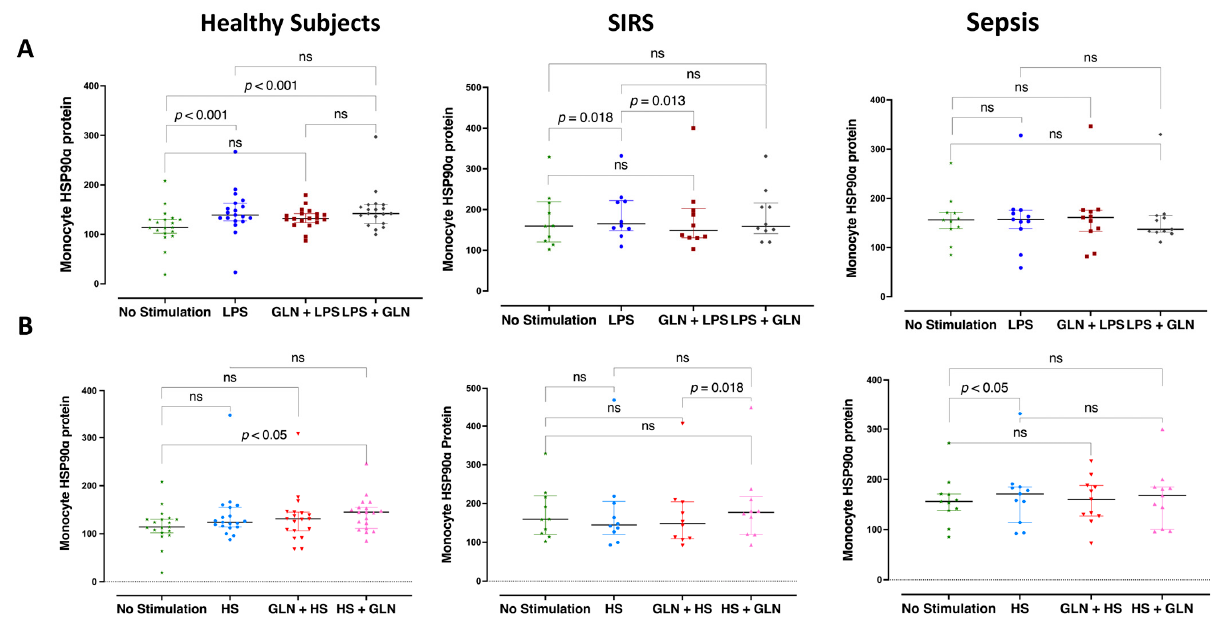
Figure 3. Glutamine effect on heat shock protein 90 α expression in monocytes (mHSP90 α ) within 4 h of LPS or HS stimulation. ( A ) LPS increased the mHSP90 α expression in the PBMCs of healthy subjects and patients with SIRS (trauma) but not in patients with sepsis. Glutamine before LPS decreased the induced mHSP90 α protein expression in SIRS but increased it in healthy subjects when given after LPS. Either way, glutamine did not affect the monocyte HSP90 α protein expression in sepsis. ( B ) HS increased the mHSP90 α expression in the PBMCs in all groups, almost 10-fold in sepsis compared to the other groups. Glutamine before or after HS stimulation showed a non-significant decreasing trend in sepsis but a significant increase in SIRS and healthy subjects when given after HS induction. Abbreviations: SIRS = systemic inflammatory response syndrome; HSP = heat shock protein; mHSP90 α = monocyte HSP90 α protein; LPS = lipopolysaccharide; HS = heat shock; ns = not significant. Each dot represents an individual patient; dots of different colors represent different stimulant situations as indicated in axis labels; lines represent medians and bars interquar- tile ranges. There were no missing data; pairwise comparisons were tested using the related samples Friedman’s two-way analysis of variance by ranks; p values were determined using the Wilcoxon signed-ranks test between pairs of no stimulation and stimulation with or without GLN before or after LPS or HS, adjusted by the Bonferroni correction for multiple tests.